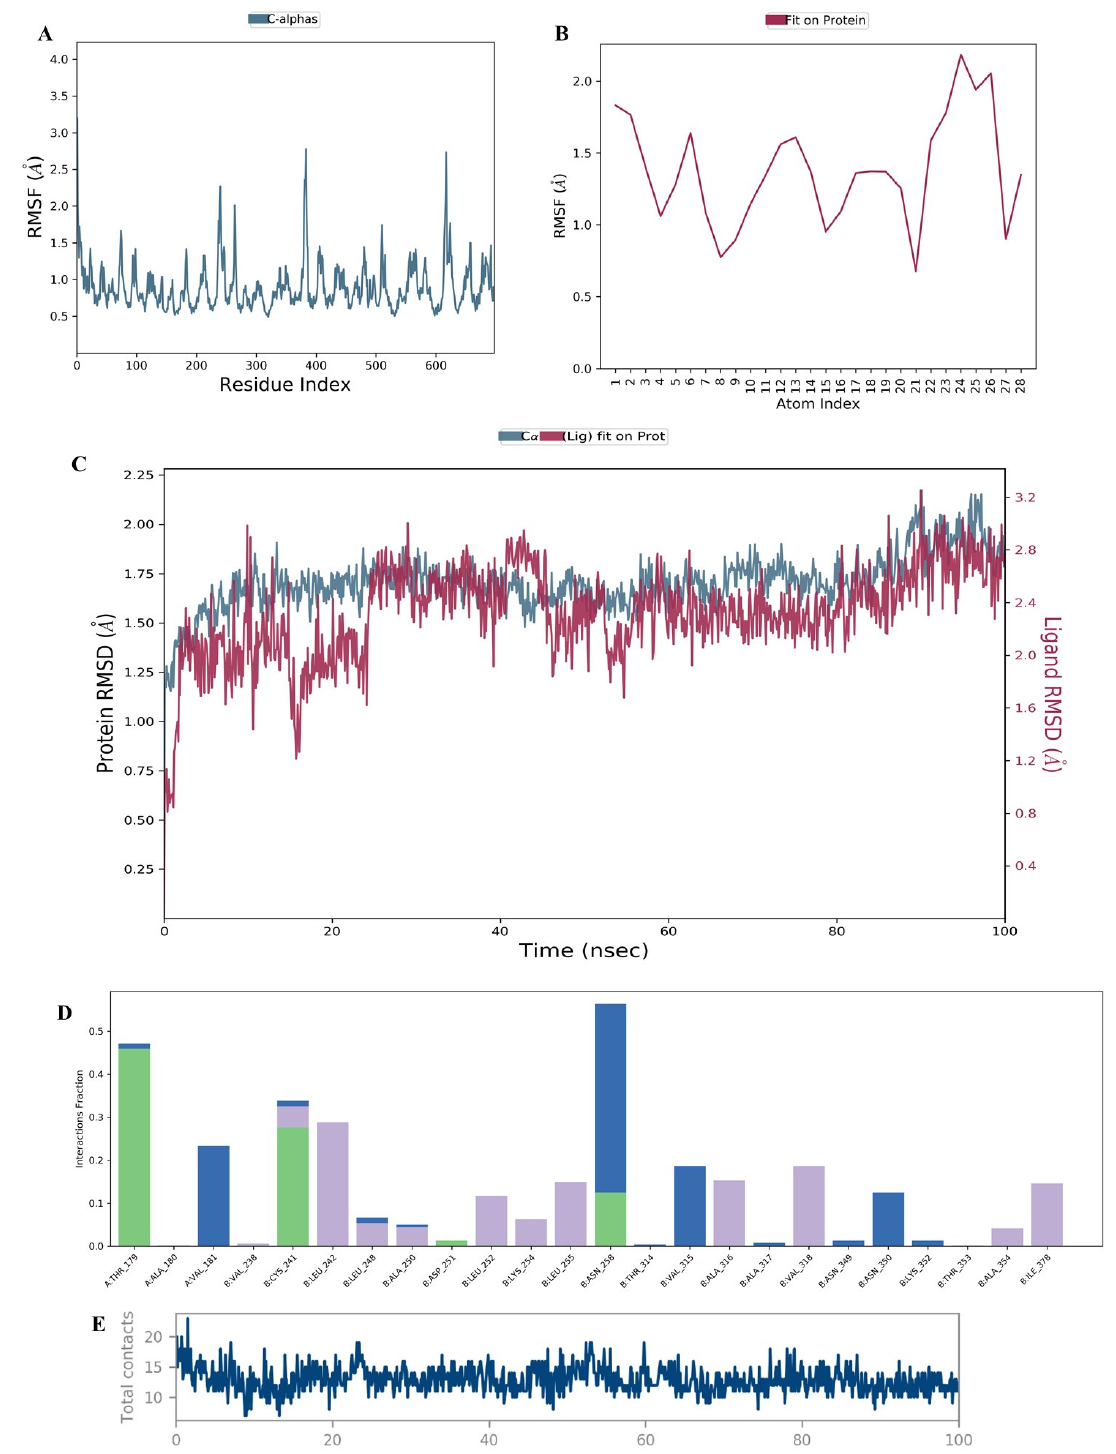
Figure 3. The outcomes of the MD analysis of ligand 1A2 with colchicine-binding domain of tubulin (PDB: 1SA0) over simulation period of 100 ns, represented by: ( A ) protein-based RMSF pattern; ( B ) ligand-based RMSF analysis; ( C ) perturbations recorded with ligand and its binding within CBS as indicated by change in RMSD; ( D ) protein–ligand contact diagram generated from hydrogen bonding, hydrophobic interactions, and formation of water bridge over the simulation period; ( E ) protein–ligand contact trajectory over the simulation time.